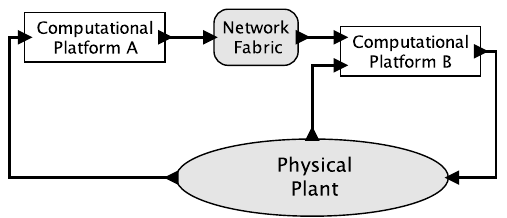
Figure 1. Structure of a simple cyber-physical system